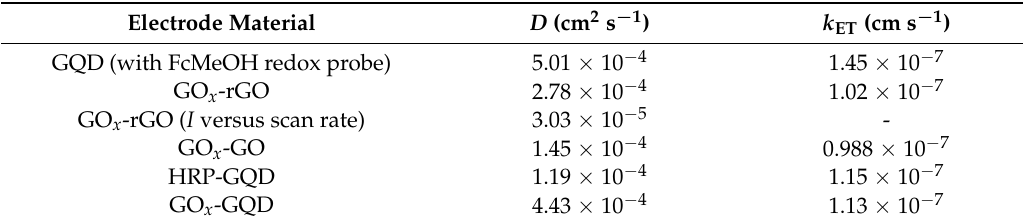
Table 1. Summary of physicochemical parameters, diffusion coefficient ( D ), and electron transfer rate ( k ET